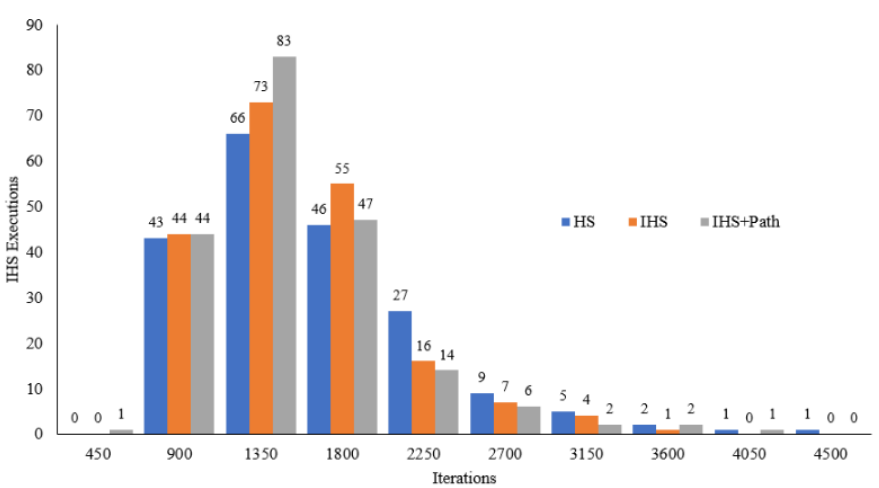
Figure 7. Convergence frequency of different algorithms for the 84-bus test system.